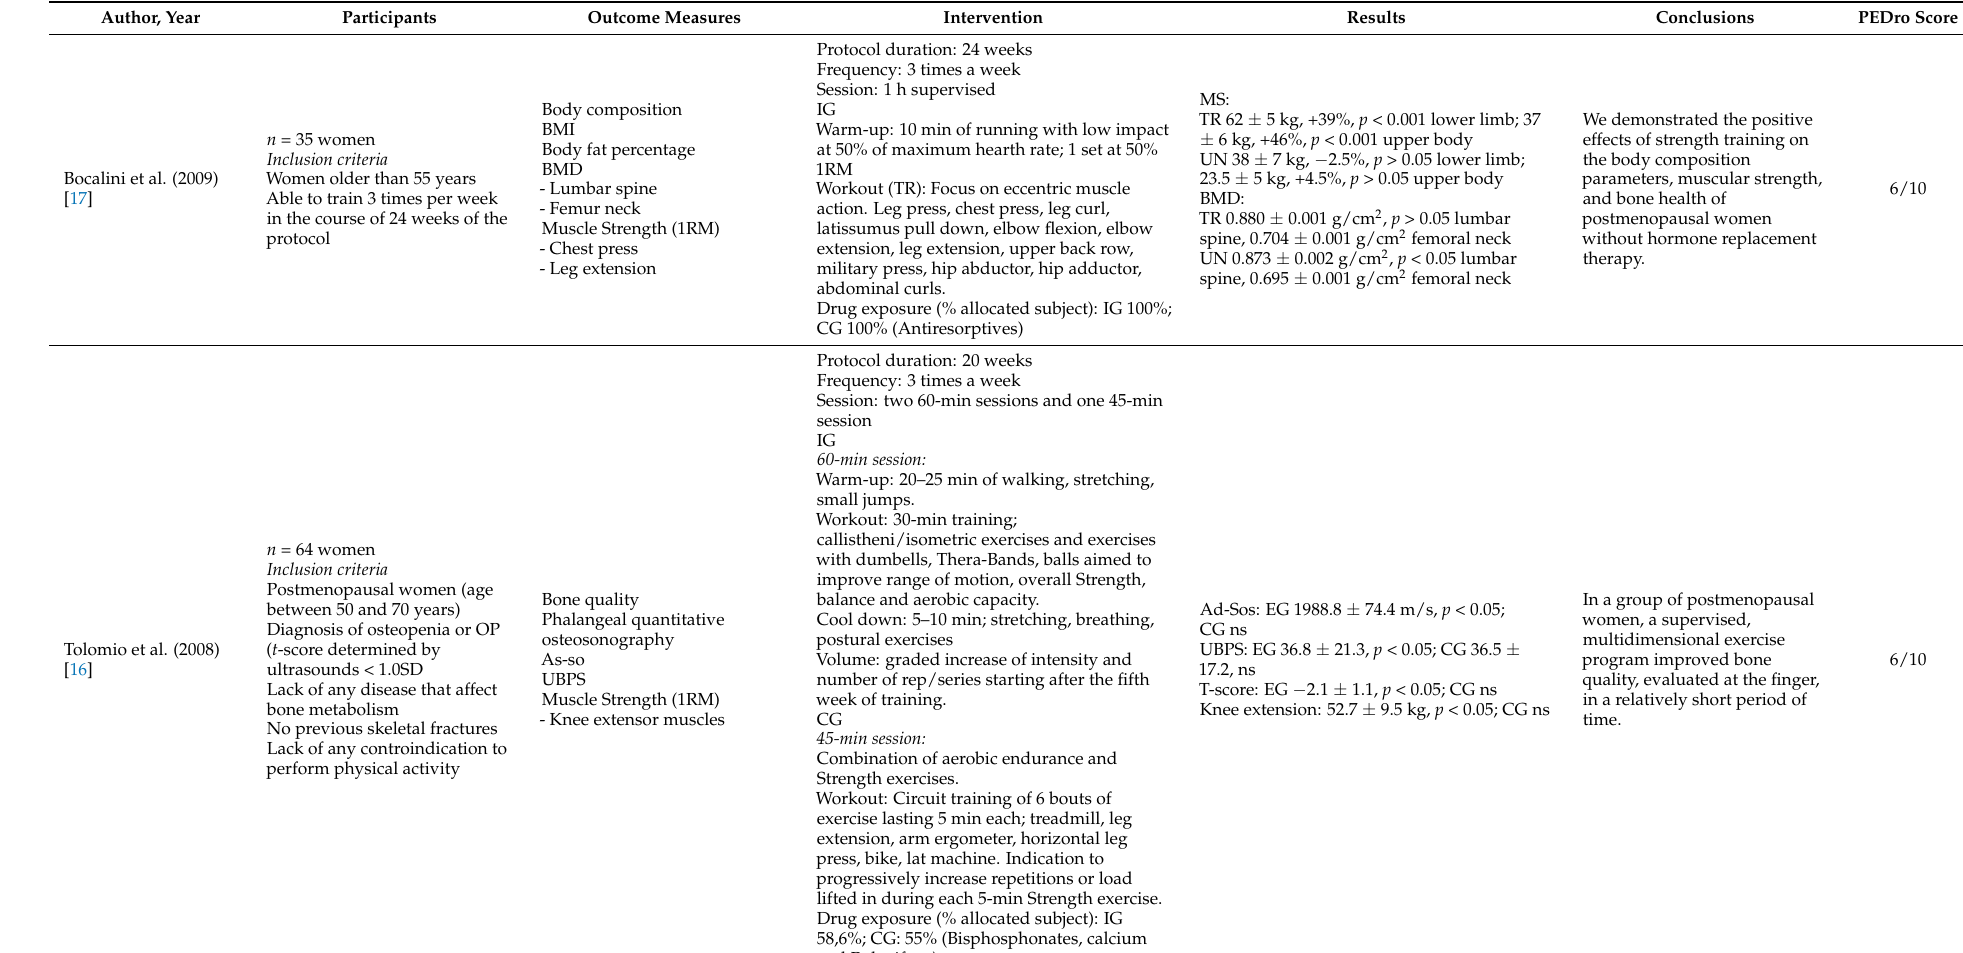
Protocol duration: 24 weeks Frequency: 3 times a week Session: 1 h supervised IG